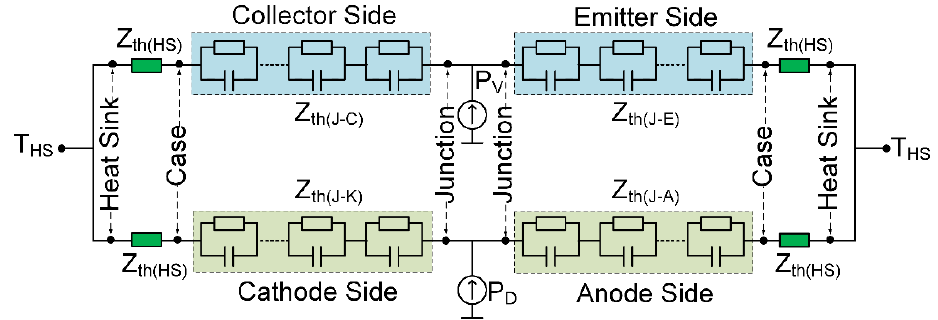
Figure 6. Equivalent thermal model of individual press-pack IGBT